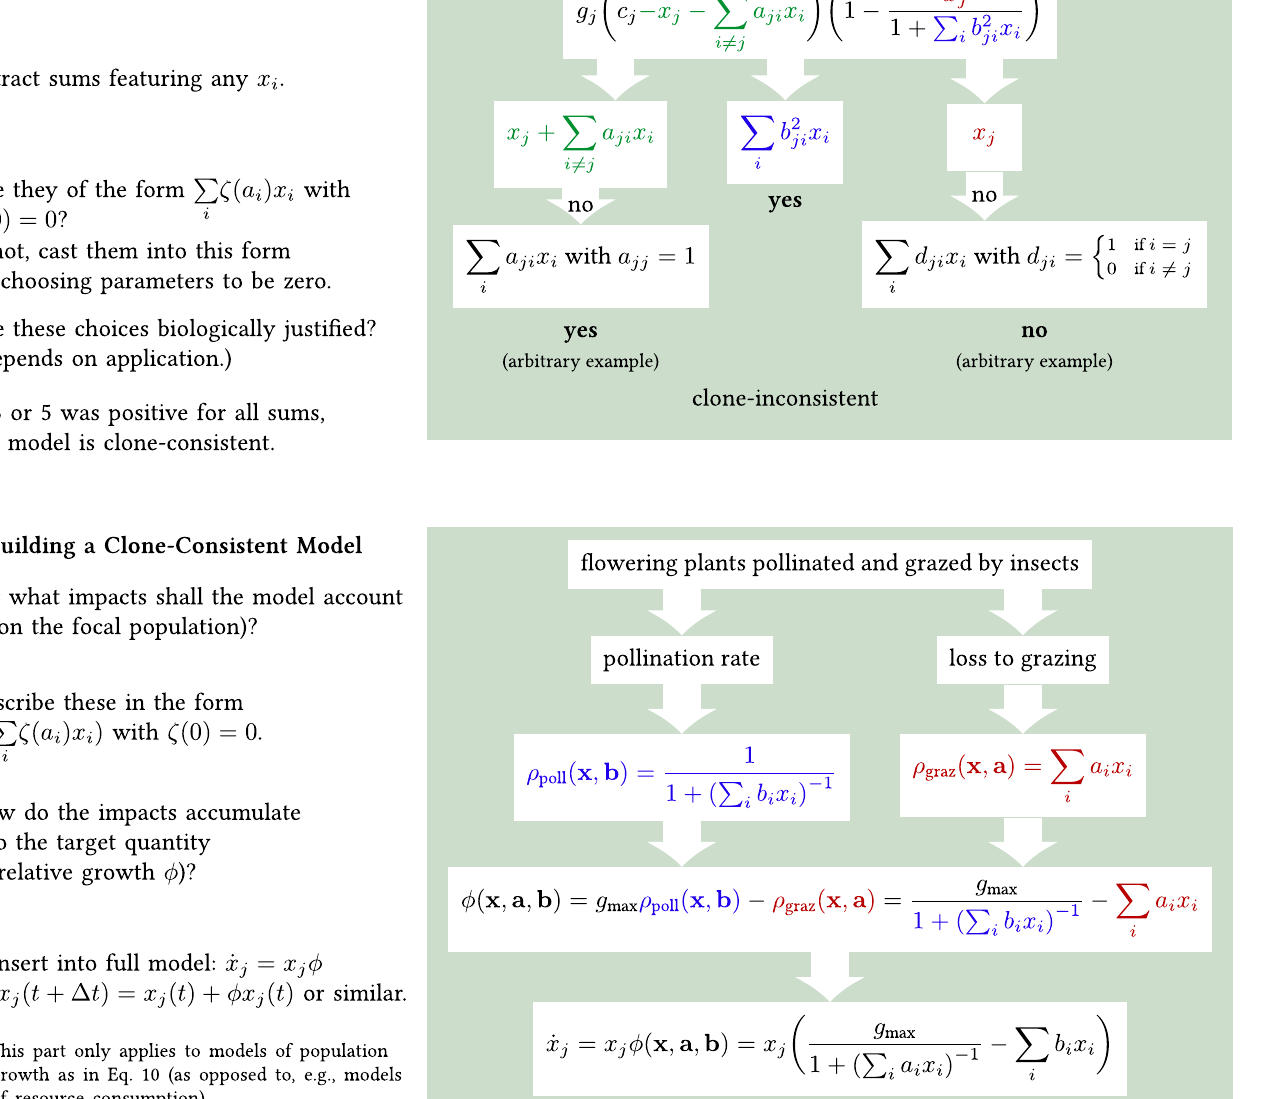
PLOS Computational Biology | https://doi.org/10.1371/journal.pcbi.1008635 February8,